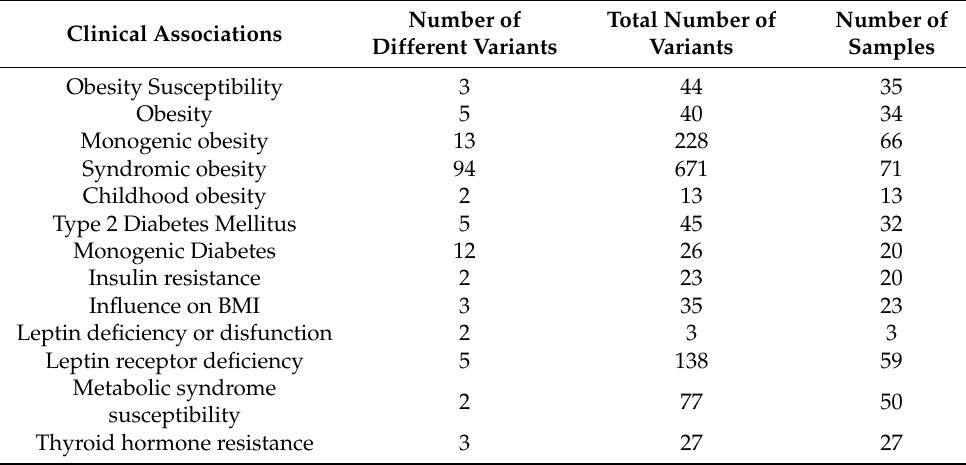
Table 3. Clinical association of the identified variants potentially associated with obesity. Clinical